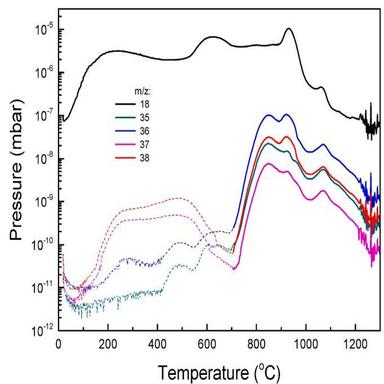
RGA traces of the four m/z = 35, 36, 37,38 HCl-associated peaks, corresponding to the Cl and HCl with the two stable 35Cl and 37Cl isotopes. The color scheme differs from that in for clarity. The dashed sections below ~700 ◦C represent the range with significant background from other compounds. (For interpretation of the references to color in this figure legend, the reader is referred to the Web version of this article.)